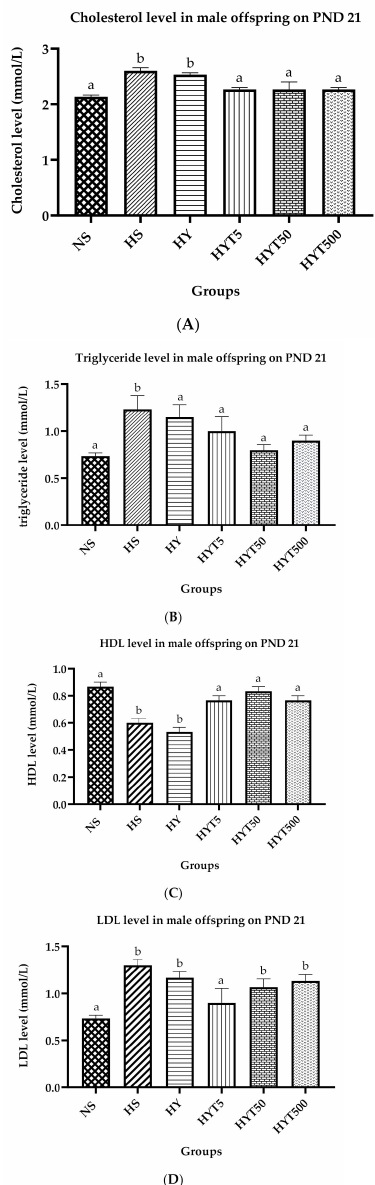
Figure 5. ( A ). Cholesterol levels in male offspring on PND 21. ( B ). Triglyceride levels in male offspring on PND 21. ( C ). HDL levels in male offspring on PND 21. ( D ). LDL levels in male offspring on PND 21. Different letters indicates a significant difference at p <